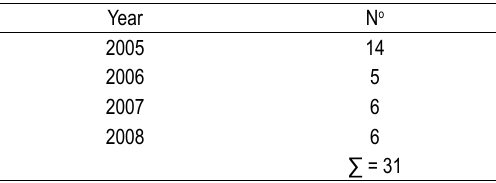
Table 1. Frequency of treated spina bifida cases from janu - ary 2005 to december 2008